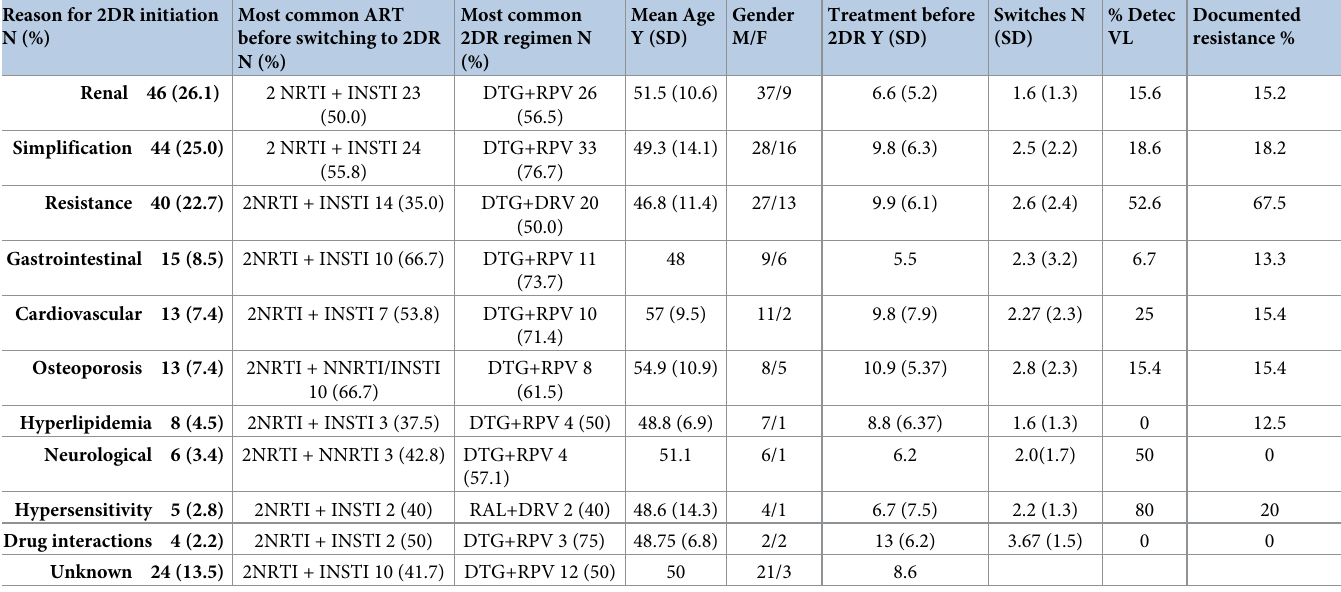
Table 2. 2DR switches-reasons, regimens and patient